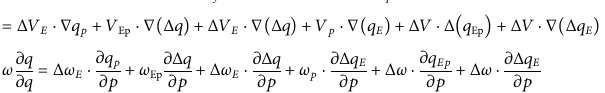
Frontiers in Earth Science |